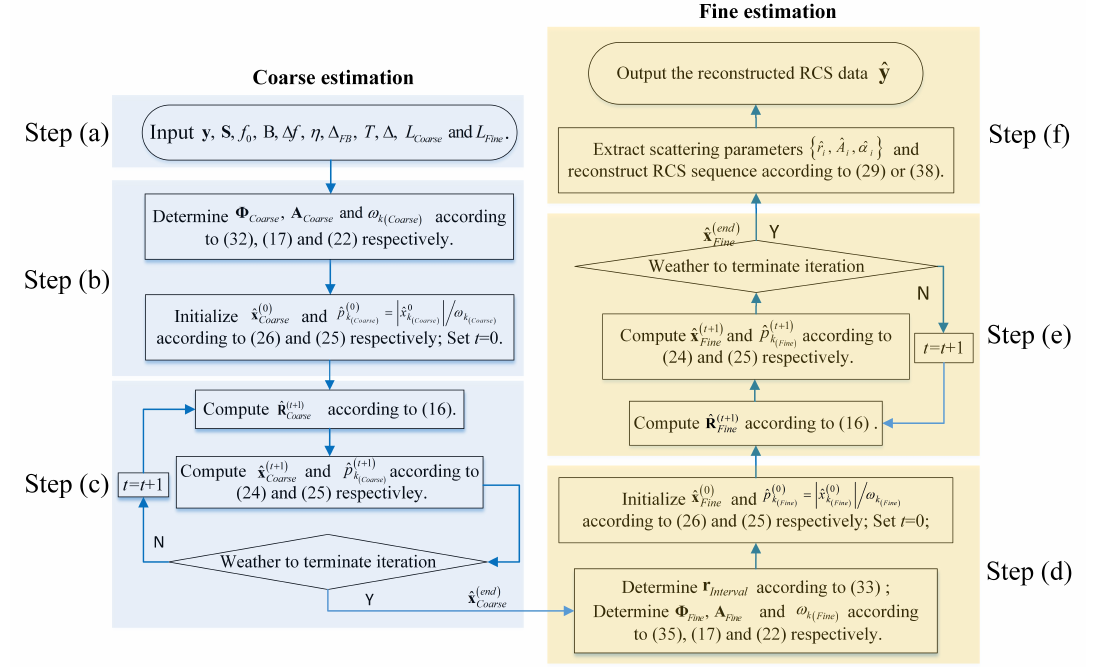
Figure 4. Flowchart of the proposed DE–GTD–SPICE